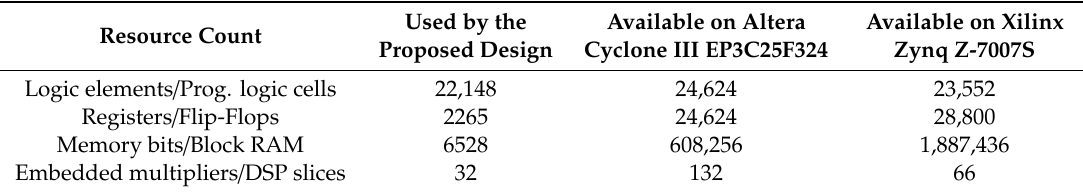
Table 1. Comparison of requested and available